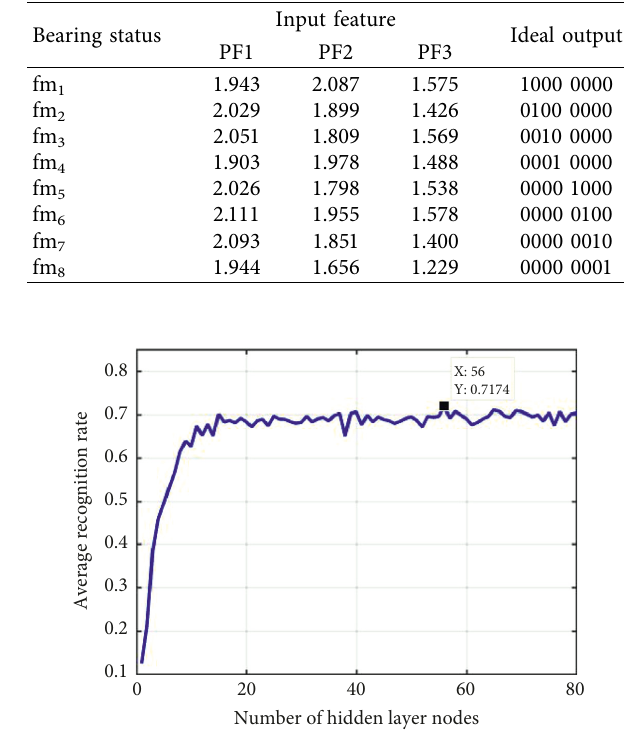
Figure 10: The average recognition rate